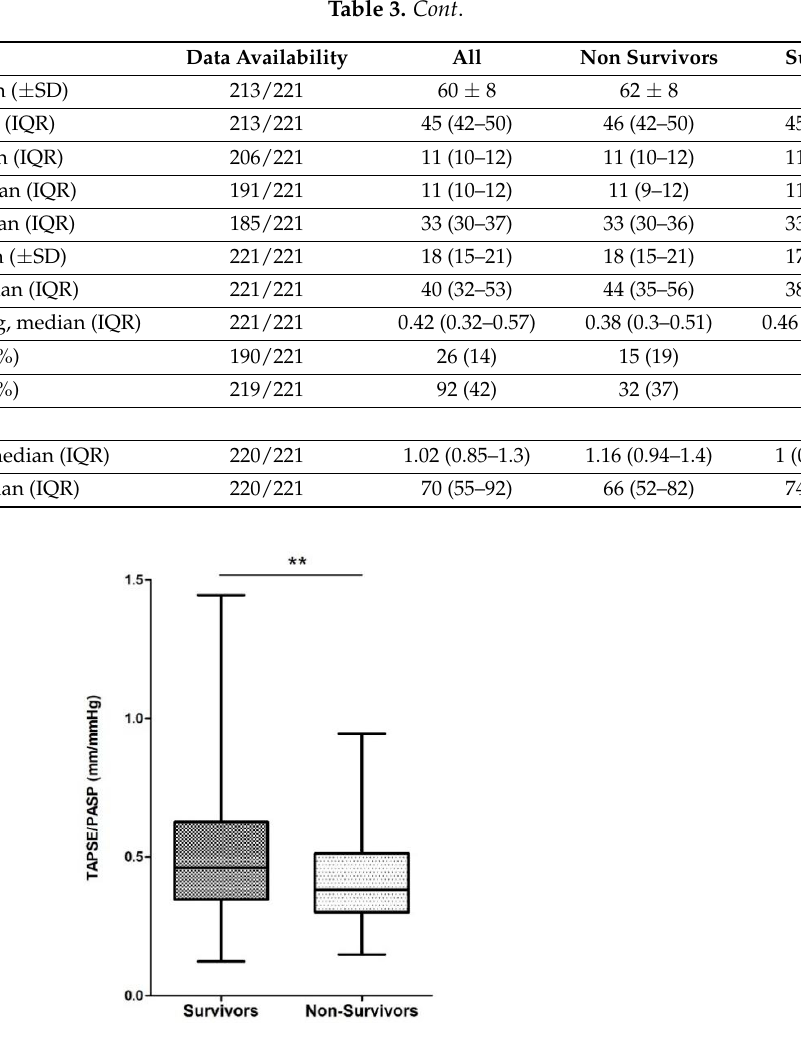
Figure 5. Box plots comparing TAPSE/PASP values in survivors and non-survivors. Boxes represent median with IQR. ** p < 0.01.